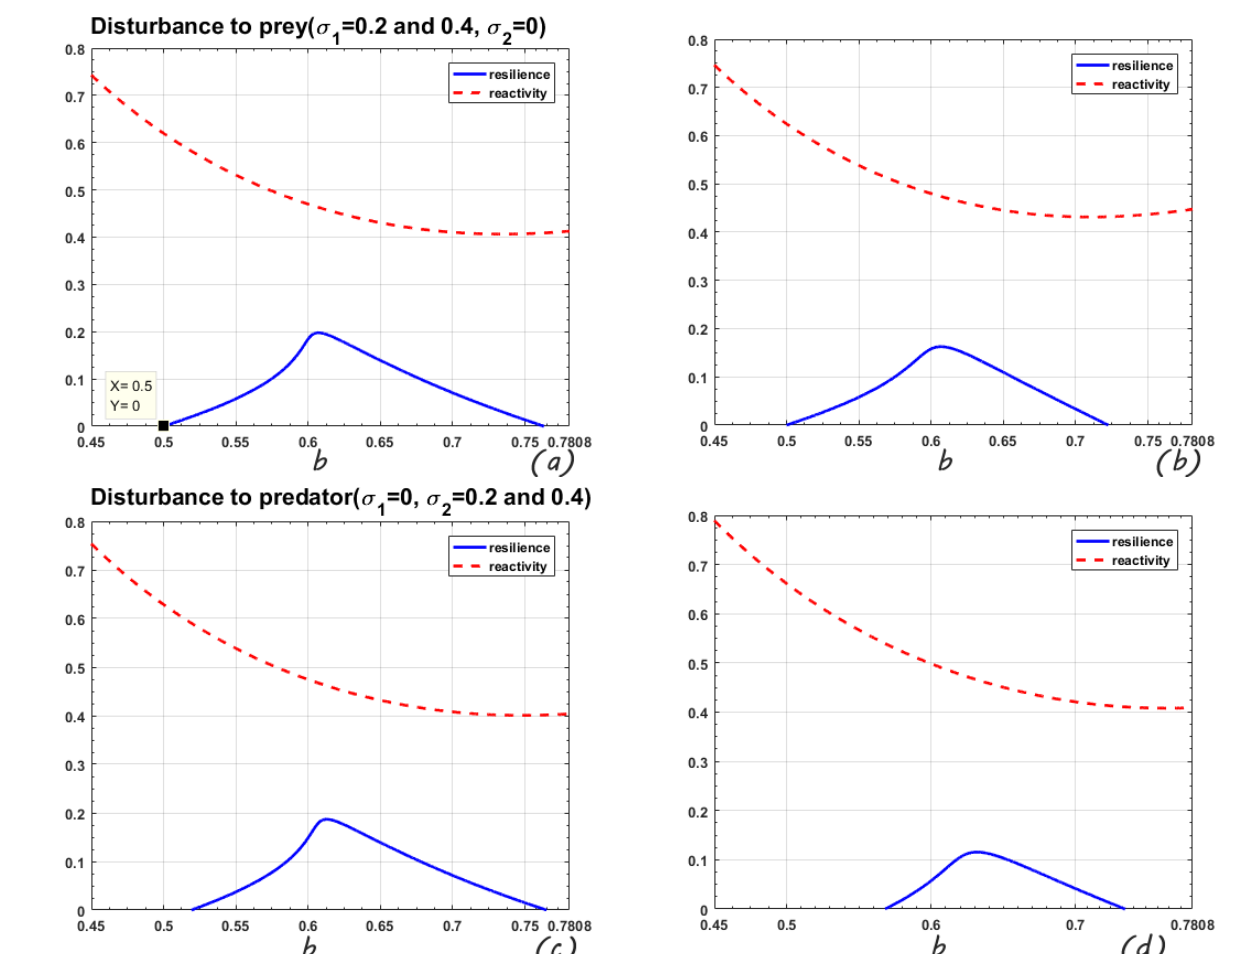
Figure 3. Resilience and reactivity (in the mean-square sense) of the positive equilibrium of (11). The variable parameter is b , fixed parameters a = 2.0, c = 0.5. In ( a ), σ 1 = 0.2, σ 2 = 0. In ( b ), σ 1 = 0.4, σ 2 = 0. In ( c ), σ 1 = 0, σ 2 = 0.2. In ( d ), σ 1 = 0, σ 2 = 0.4. Table 1 is a brief description of Figure